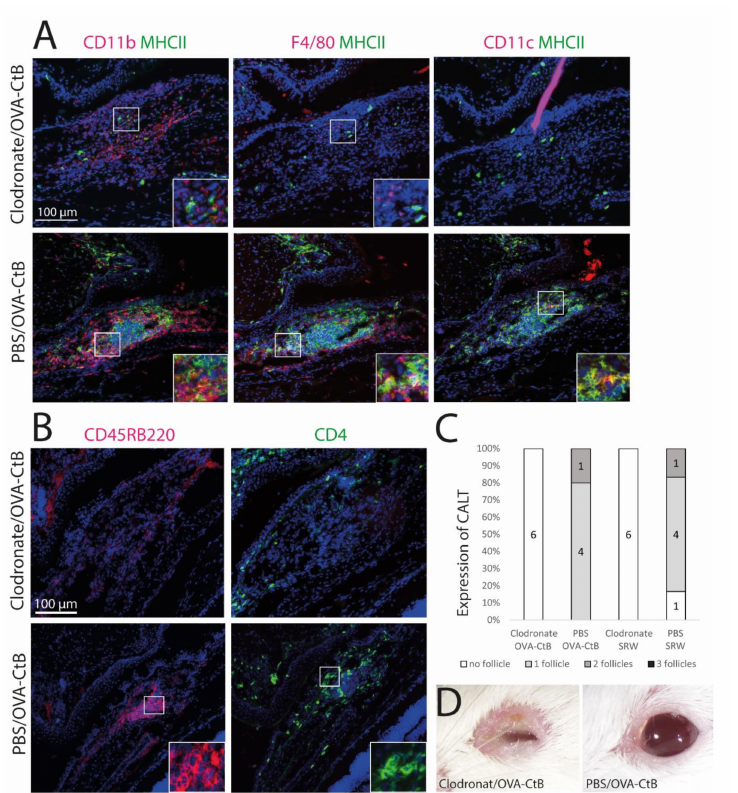
Figure 4. The development of CALT depends on the presence of APCs. ( A + B ) Immunohistochemistry of acetone-fixed cryosections ( A ): green: MHC II; red: CD11b, CD11c, F4 / 80; ( B ): green: CD45RB220 (B cells); red: CD4 (T cells); blue: nuclei; bar = 100 µ m). After sub-conjunctival clodronate injections, only di ff use cellular infiltration without functional MHC II + cells were present in the nictitating membrane (upper rows), whereas in PBS injected control mice, organized and functional CALT was present (lower rows). ( C ) The depletion of APCs by sub-conjunctival clodronate injection leads to a lack of CALT after OVA / CtB or SRW stimulation. ( D ) APC depleted mice su ff ered from severe blepharitis compared to PBS control mice, after OVA / CtB stimulation (8 × / 2